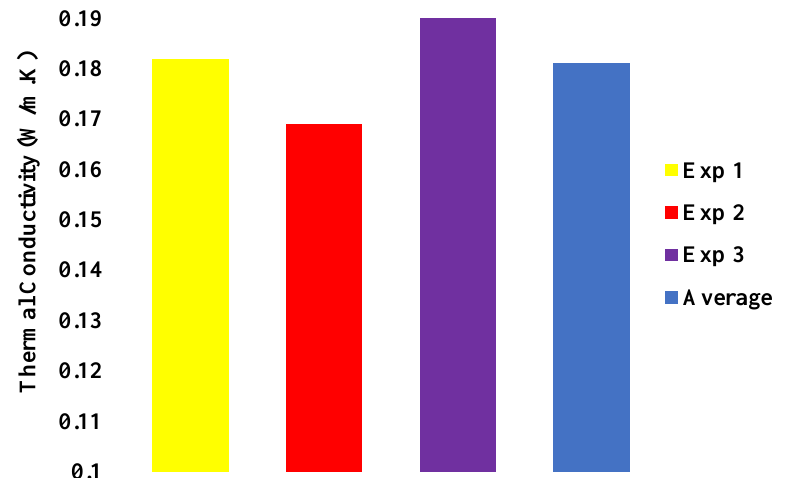
Figure 5. Thermal conductivity for Arachidic acid.